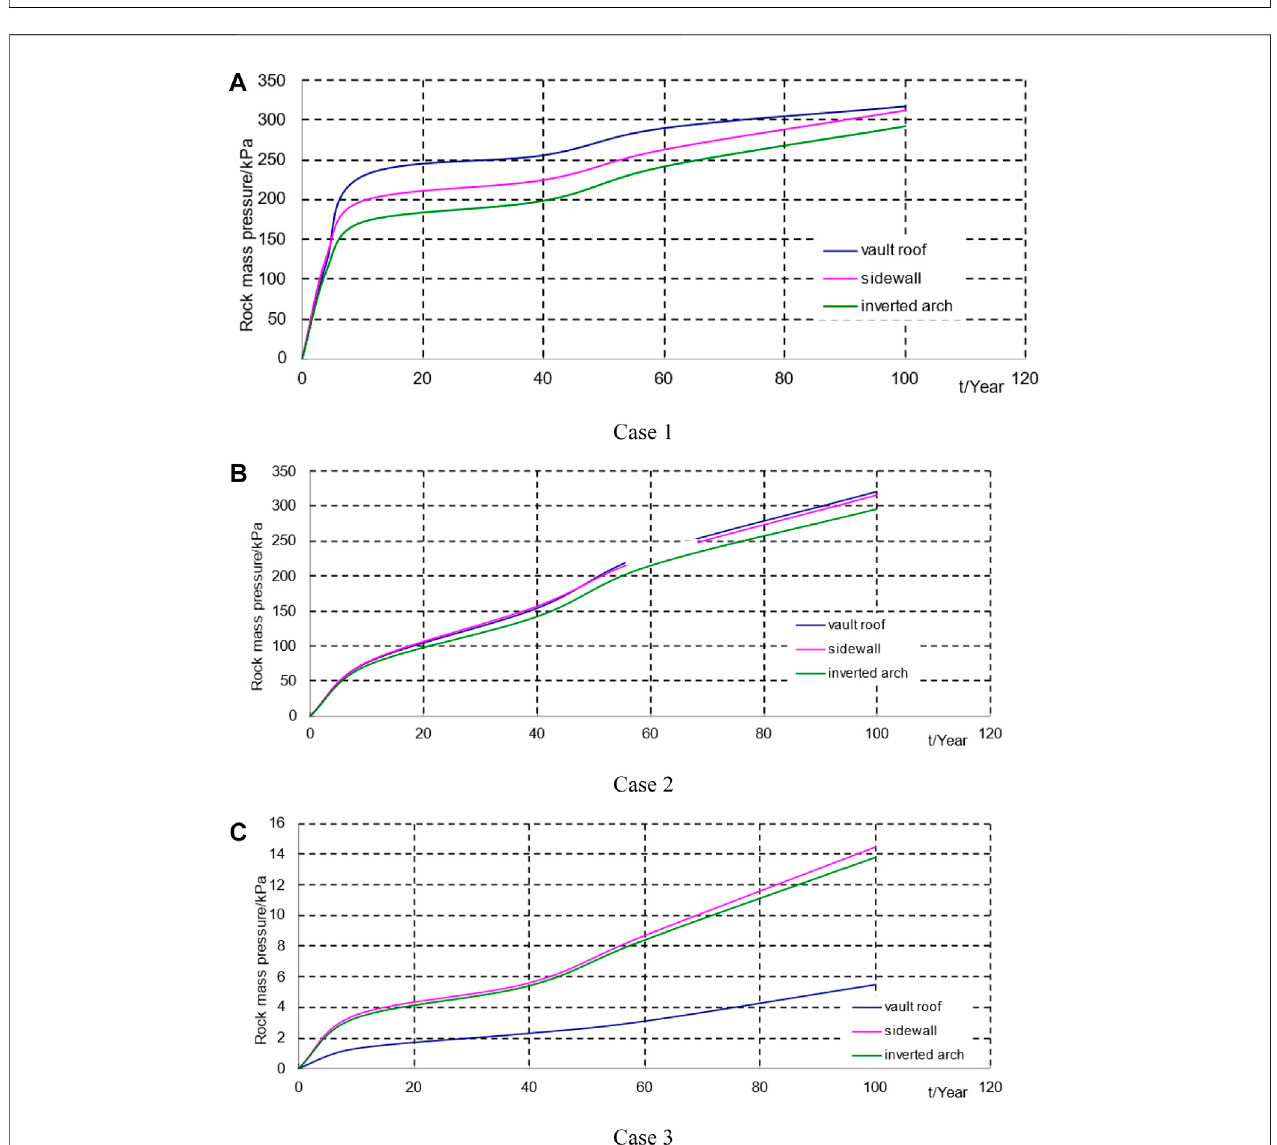
FIGURE 6 | Variations in the pressure the secondary lining undertakes with time. (A) Case 1. (B) Case 2. (C) Case 3.